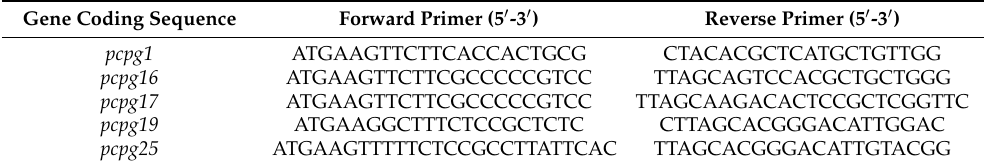
Table 1. Primer pairs designed for the coding sequences used for amplification of each endoPG from P. cinnamomi